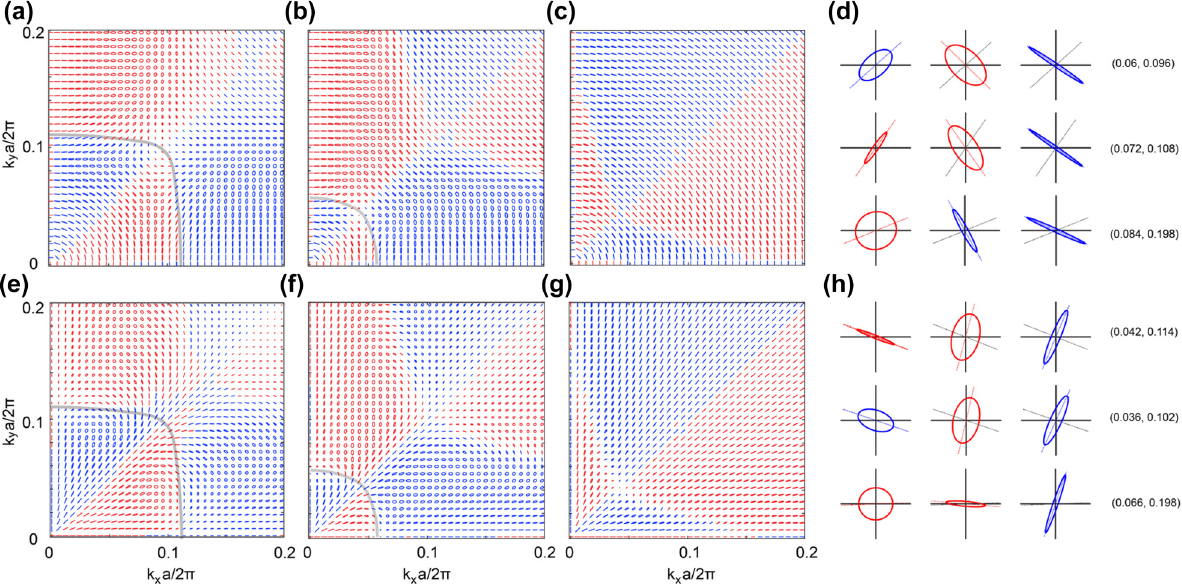
Figure 2: Polarization synthesis based on the ZnO/Ag hybrid meta-surface. Polarization ellipses as a function of wavevectors for s -pol = 0.919 × 2 𝜋 c/a ( 𝜆 = 1197 nm), when the metasurface is (a) in its static state, and under an excitation of 266 nm light at incident light at 𝜔 0 0 a pump fluence of (b) 1.31 mJ/cm 2 ( 𝛥 Re( 𝜀 ) = − 0.326) and (c) 2.63 mJ/cm 2 ( 𝛥 Re( 𝜀 ) = − 0.949). (d) Polarization ellipses across the three states , k ) = (0.06, 0.096), (0.072, 0.108), and (0.084, 0.198). (e)–(g) The same as panels (a)–(c), but for p -pol illumination. (h) Same as at ( k x y , k ) = (0.042, 0.114), (0.036, 0.102), and (0.066, 0.198). In all panels, the red (blue) ellipses denote panel (d) but for p -pol illumination at ( k x y right(left)-handed polarization. For panel (d) and (h), the dashed line in each panel denotes the main axis of the